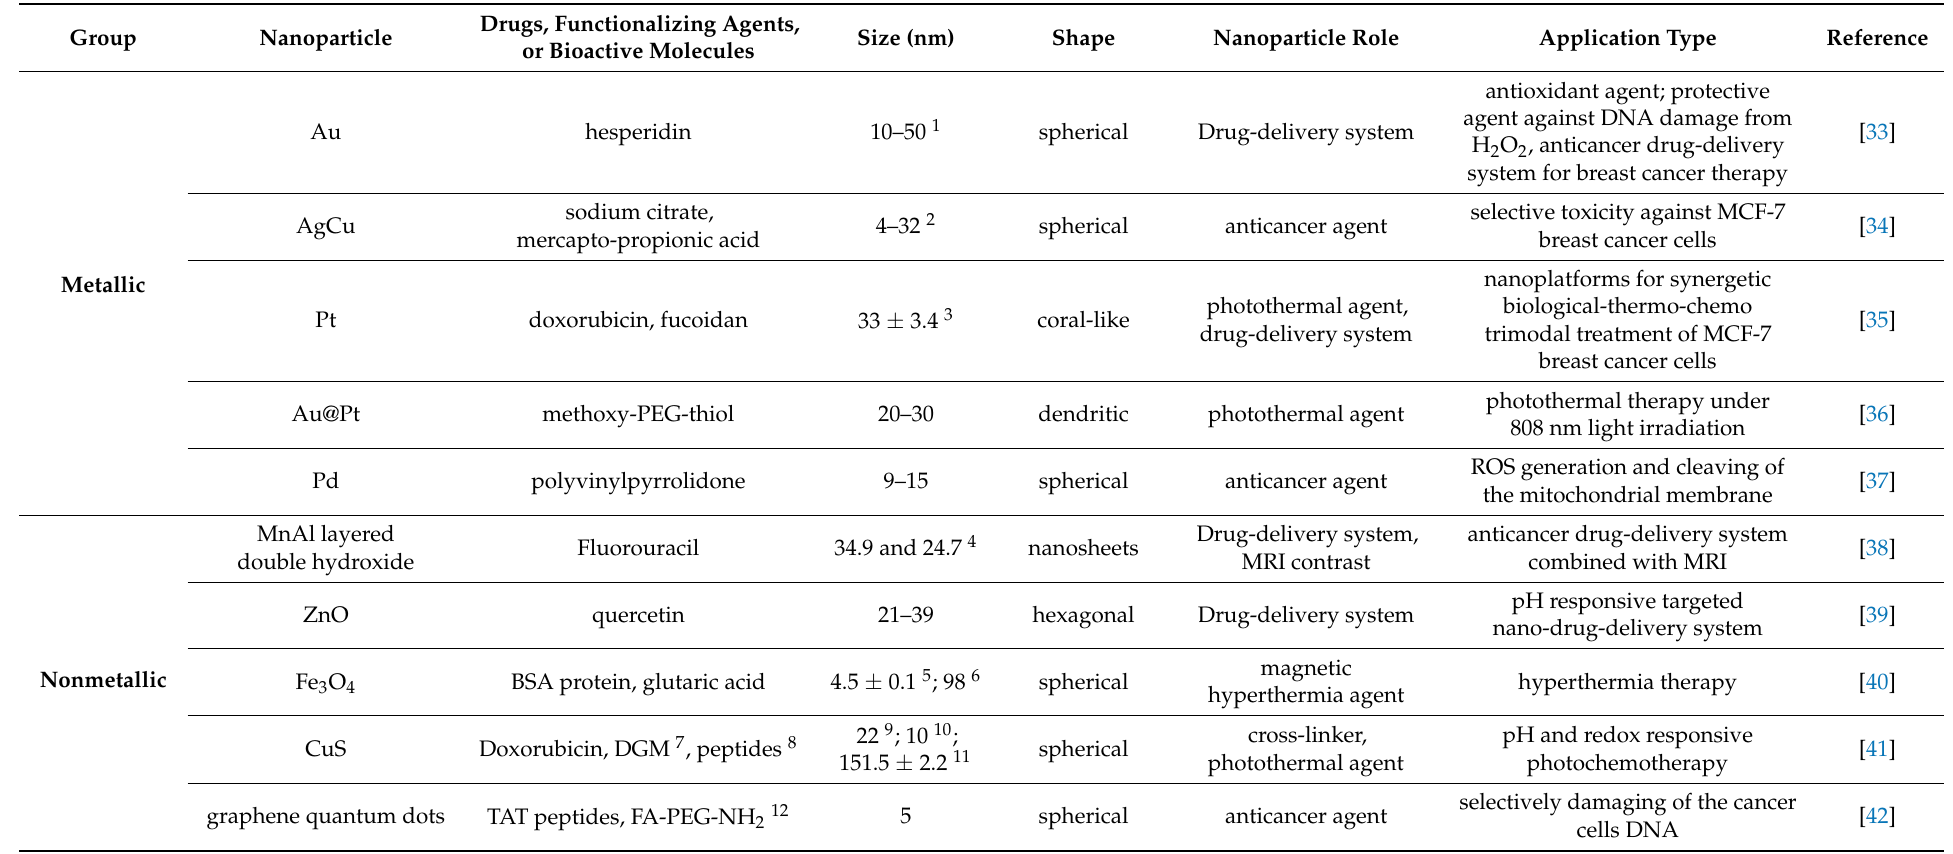
Table 1. The potential applications of nanoparticles in smart